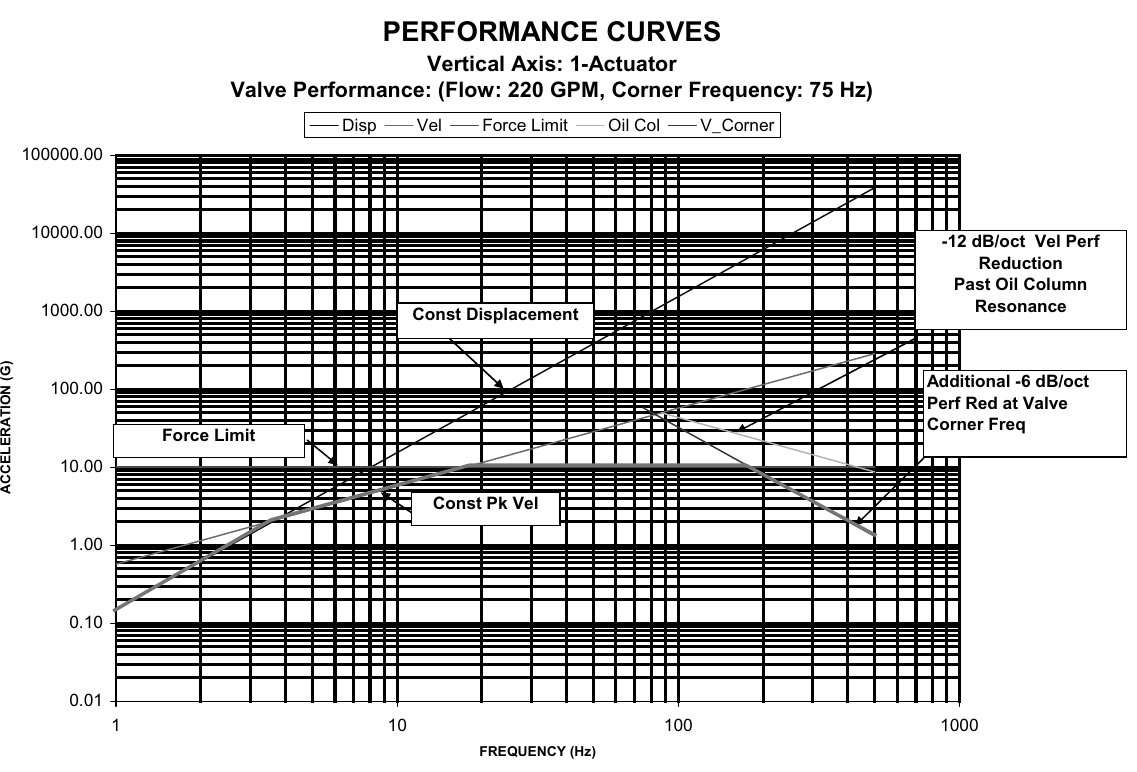
Fig. 1. Single actuator performance